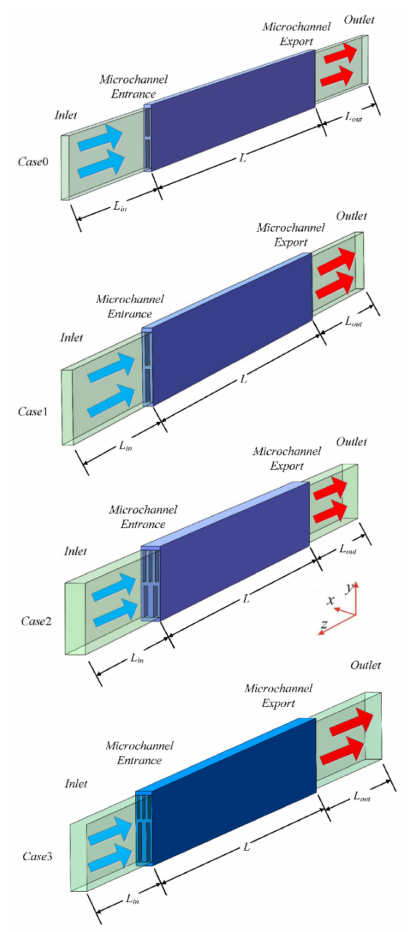
Figure 2. Simulation domain of different